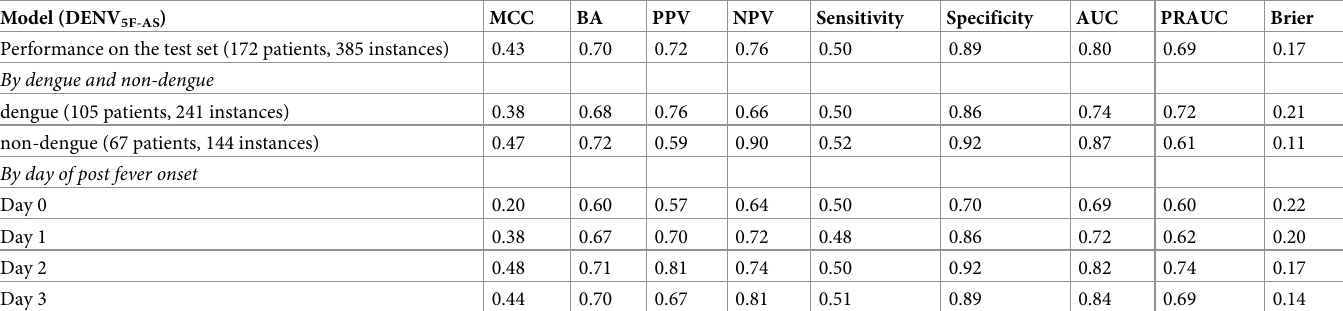
midline reflecting less impacts on the predictions. The fourth most contributing feature was age (mean absolute SHAP = 0.050) where the younger mostly contributed to increased pre- dicted risk of plasma leakage and vice versa (Spearman’s rho = -0.57, p < 0.001). Lastly, AST increased the predicted risk of plasma leakage when its values were mostly higher than the average in the range and vice versa (Spearman’s rho = 0.85, p < 0.001). Visually distinct groups of interactions across features illustrated as edges connecting points denote patterns. The lines connecting features for each instance in Fig 4 additionally show- cased the complexity to follow the different patterns for contributing to the outcome of plasma leakage. To explore the patterns showcased in Fig 4 and whether distinct subgroups of patients were contributing to the prediction of plasma leakage, clusters were derived by running the K- means clustering algorithm based on their distinguishing feature values. Briefly, four clusters were identified: Cluster 1 included 148 (62) instances (patients), Cluster 2–106 (44), Cluster